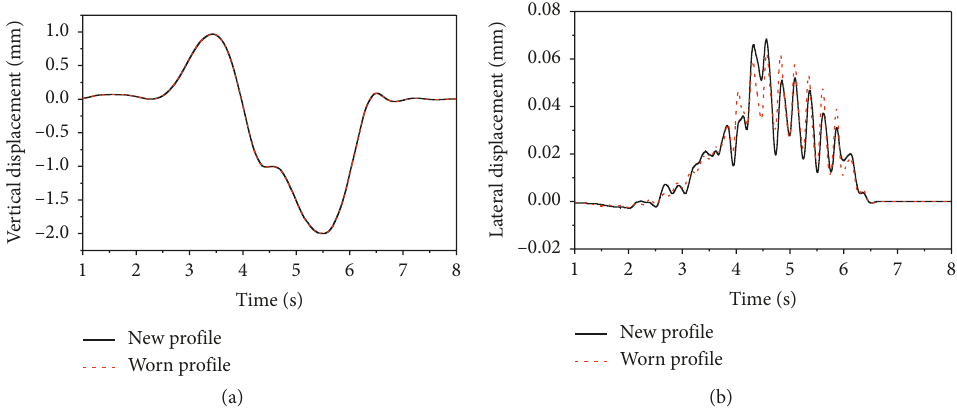
Figure 22: Time histories of displacement at the midsection of the right-side span (speed: v � 350 km/h): (a) vertical; (b) lateral.